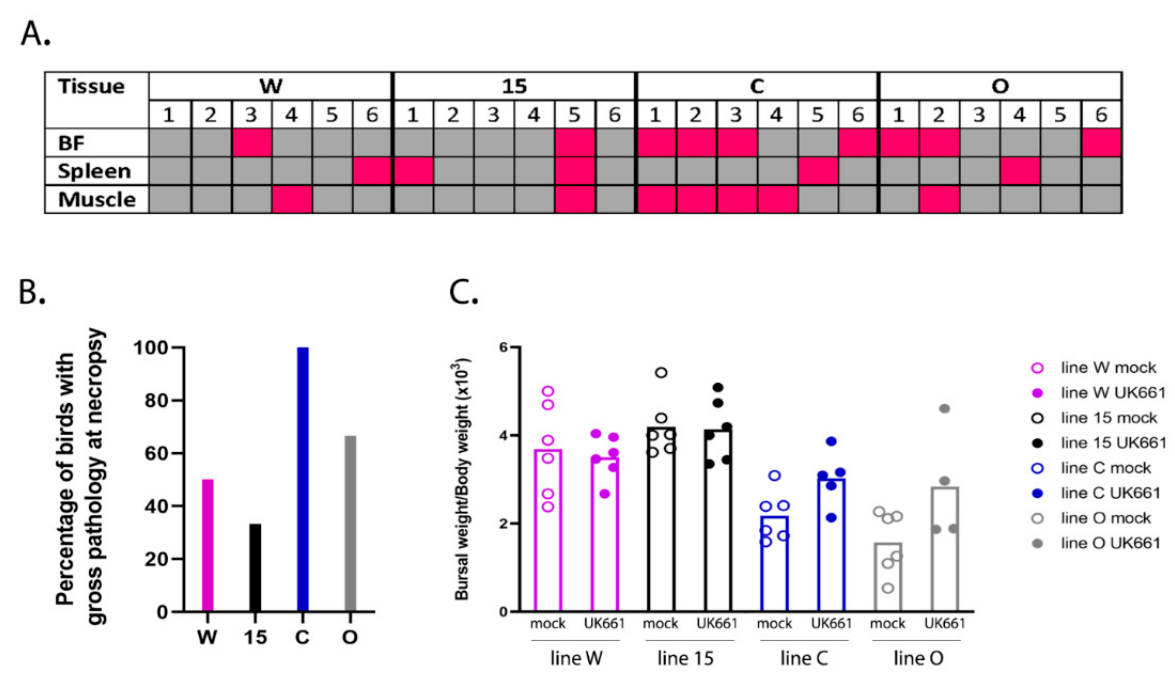
Figure 2. Line 15 had less gross pathology than the other lines in the study. Carcasses were inspected for evidence of gross pathology, including oedema, congestion and haemorrhage in the BF, enlargement and discolouration of the spleen, and haemorrhage in the pectoral and thigh muscles in 6 infected birds from each of line W, 15, C and O at 3 days post infection. Pink represents detection of pathology; grey represents lack of detected pathology ( A ). The percentage of infected birds from line W, 15, C and O showing gross detected pathology was plotted ( B ). The BF weight was determined at necropsy and expressed relative to body weight BF weight: body weight ratio × 100) for lines W, 15, C and O in mock and UK661 infected birds and plotted. Each dot represents one bird and each bar represents the average for the indicated line ( C ).